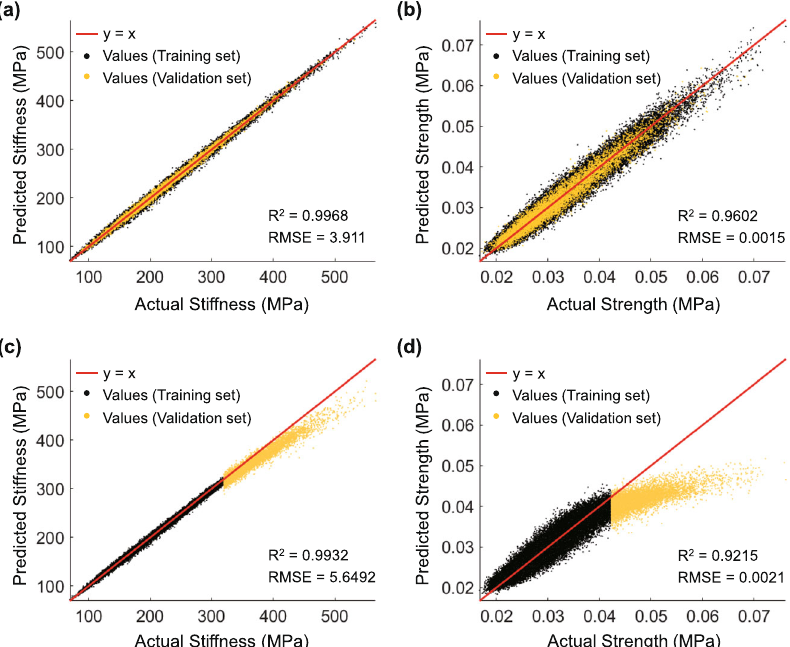
Fig. 3 DNN training results. a – b DNN training results in terms of stiffness and strength with the validation sets randomly selected 10% of data in the data distribution. c – d DNN training results to check generalization on an unseen domain by setting the training sets and the validation sets as 90% of data with lowest output value and 10% of data having highest output value, respectively. The coef fi cient of P y i (cid:2) y determination ( R 2 ) are calculated by the following equation: R 2 ¼ 1 (cid:2)